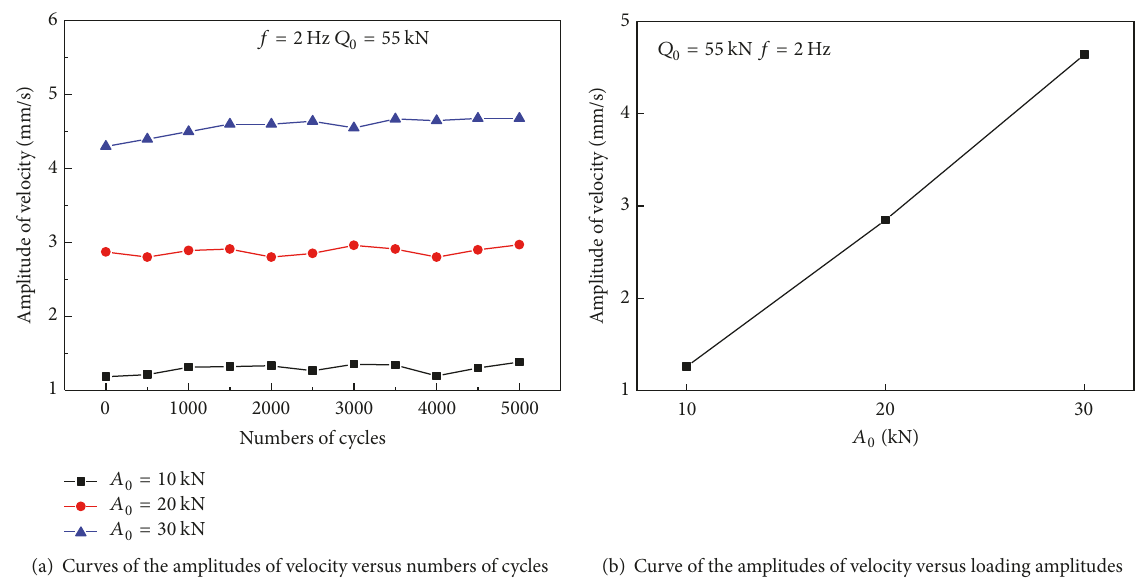
(b) Curve of the amplitudes of velocity versus loading amplitudes Figure 15: Variations of the amplitudes of velocity with variable loading